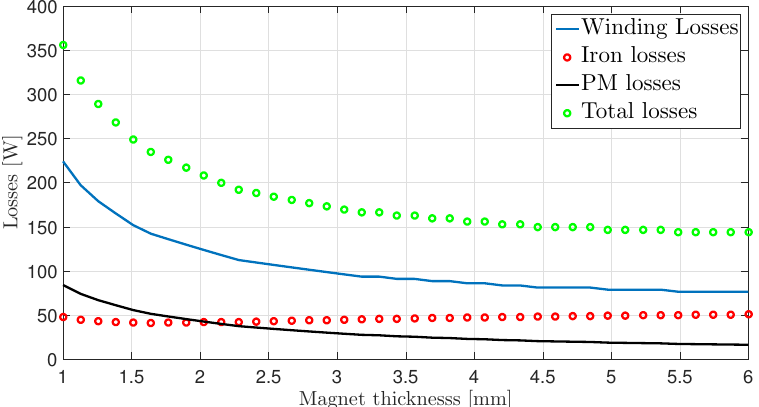
Figure 21. The losses variation with the magnet thickness.